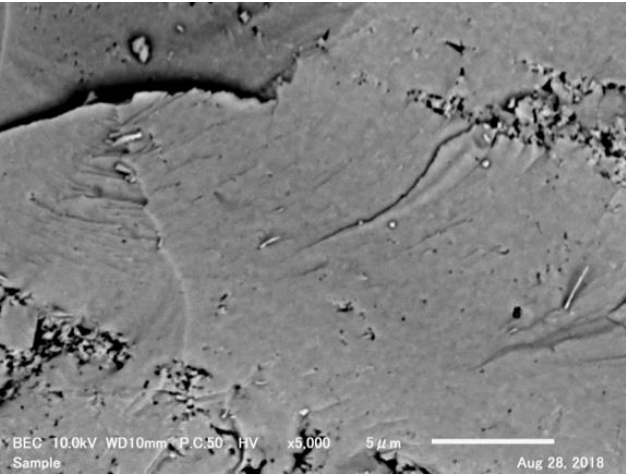
2 O 8 sintered body.